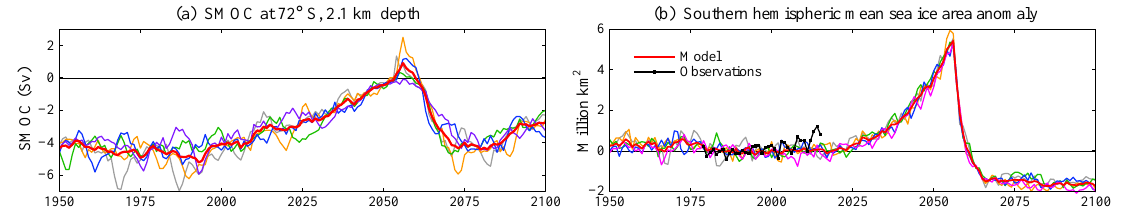
Figure 32. (a) Global meridional overturning circulation (Sv) at 72 ◦ S. Freshwater injection near Antarctica is 720Gtyear − 1 in 2011, increasing with 10-year doubling time, and half as much around Greenland. SMOC diagnostic includes only the mean (Eulerian) term. (b) Annual-mean Southern Hemisphere sea ice area anomaly (10 6 km 2 ) in five runs (relative to 1979–2000). Observations include